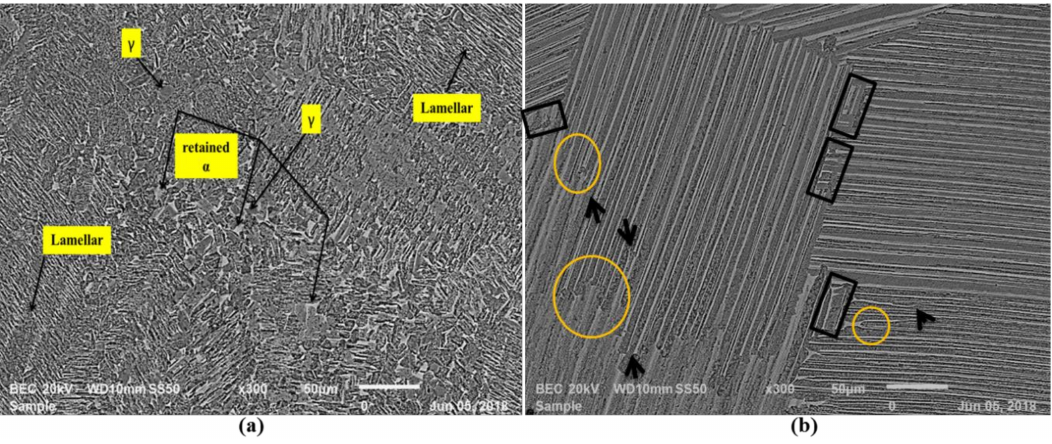
Figure 5. Microstructures of sample 2 ( γ + α 2 ) after heat treatment: at ( a ) 1200 ◦ C; and ( b ) 1430 ◦